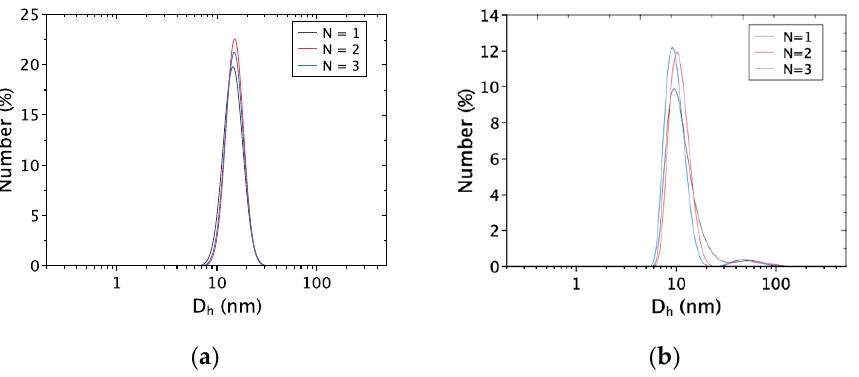
Figure 2. Dynamic Light Scattering (DLS) measurements for three independent experiments of ( a ) the AuNPs and ( b ) the AgNPs-aqueous solution (102.4 µM of metal). Number versus hydrodynamic diameter ( D h ) in nanometers.